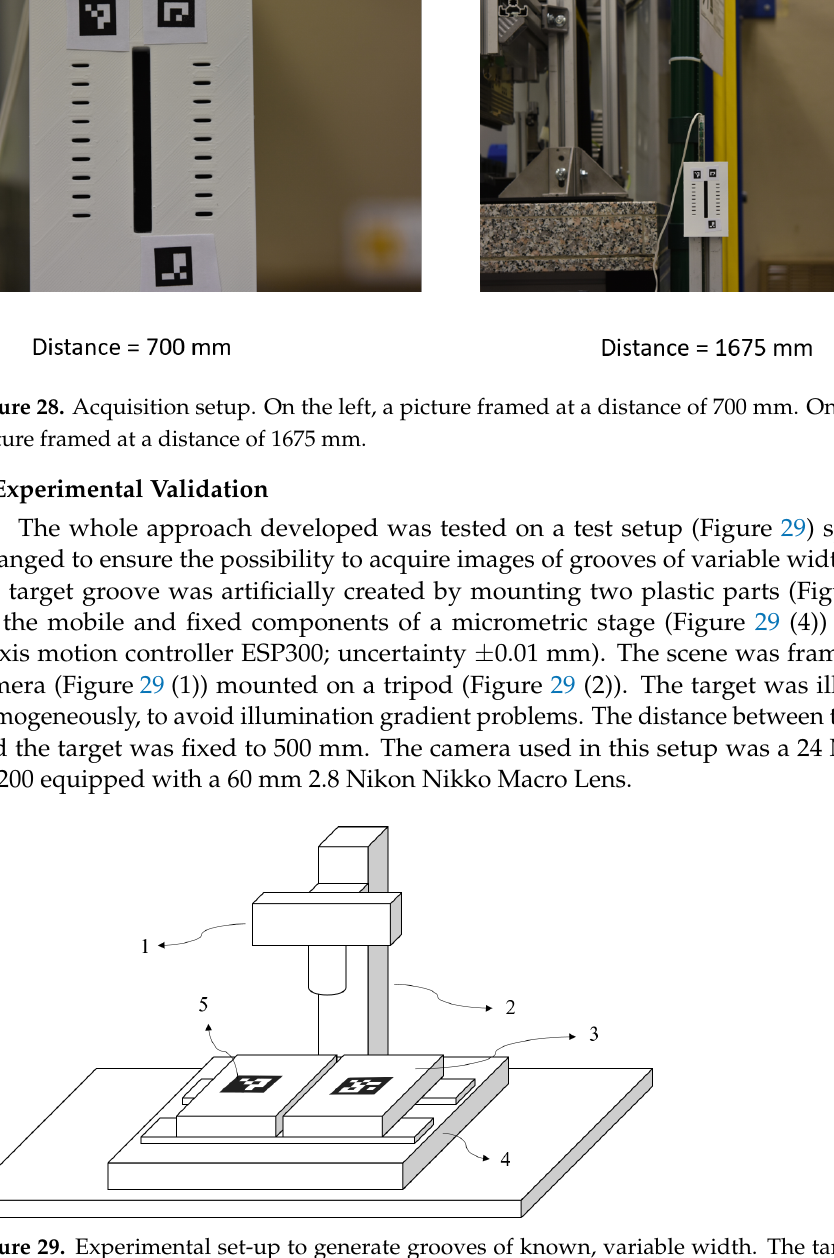
Figure 29. Experimental set-up to generate grooves of known, variable width. The target groove was artificially created by mounting two plastic parts (3) on the mobile and fixed components of a micrometric stage (4). The scene was framed with a camera (1) mounted on a tripod (2). Two fiducial ArUco markers (5) were used to identify the target-to-camera relative pose and pixel-to-millimeter conversion